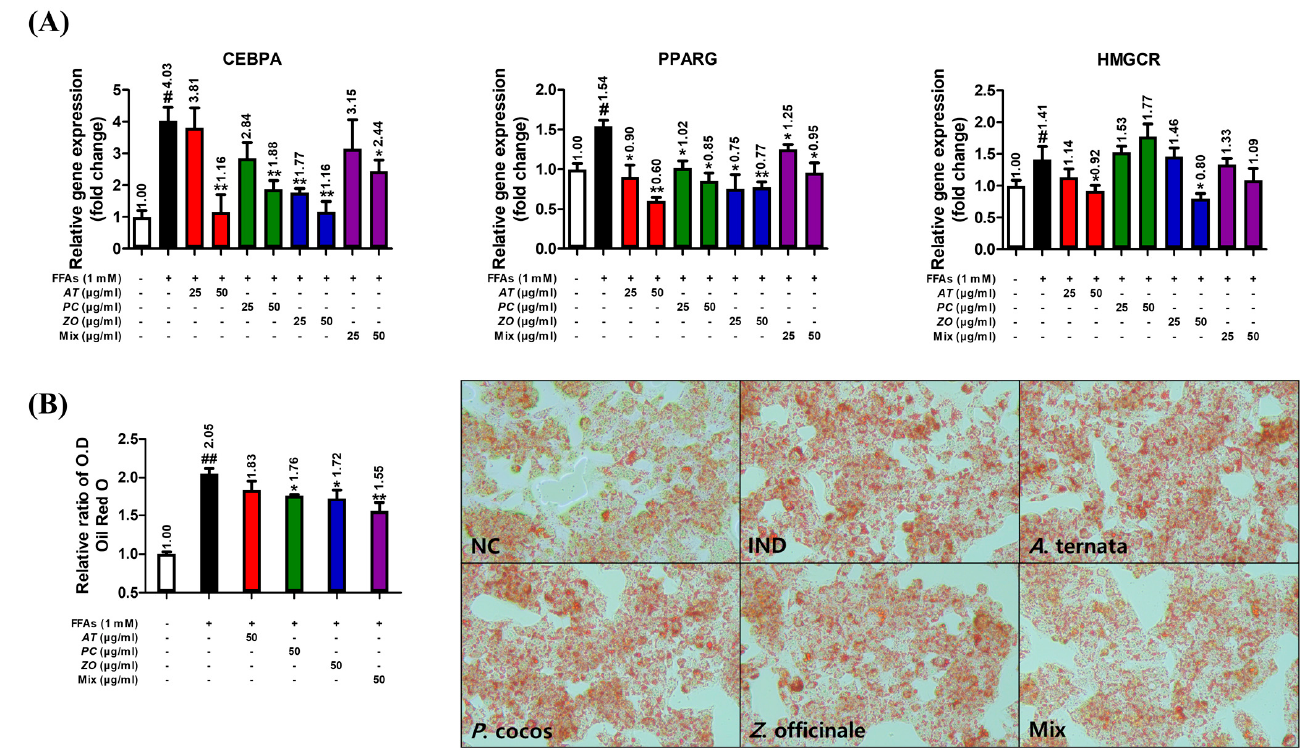
Figure 8. AT, PC, ZO, and MIX ameliorate lipogenesis in FFA-induced hepatic steatosis HepG2 cells. HepG2 cells were incubated in the absence or presence of FFAs (1 mM) with AT, PC, ZO, and MIX for six or 48 h. ( A ) Relative expressions of CEBPA, PPAR γ , ACC, and HMGCR genes were determined by qPCR. ( B ) The impact on lipid accumulation was evaluated by measuring Oil Red O staining and comparing the microscopic images. Representative images (100×) of lipid accumulation via Oil Red O staining in HepG2 cells under different conditions. The results are presented as the means ± SDs of three independent experiments. # p < 0.05, ## p < 0.01 versus the FFA-treated controls, and * p < 0.05, ** p < 0.01 versus FFA-treated HepG2 cells.